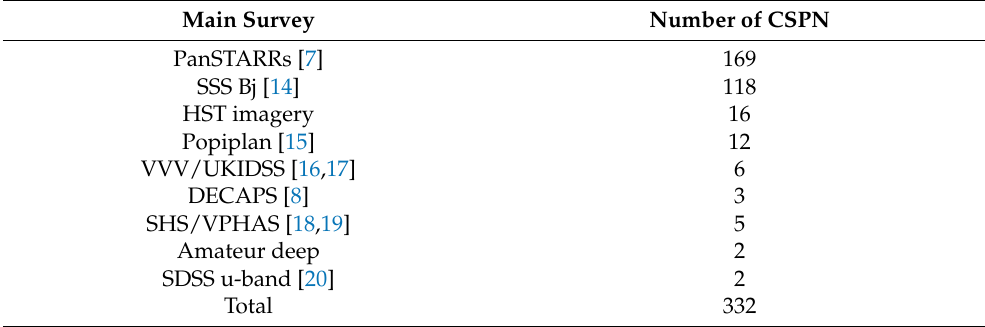
identified CSPN. For the other 83 cases, combinations of available image data were